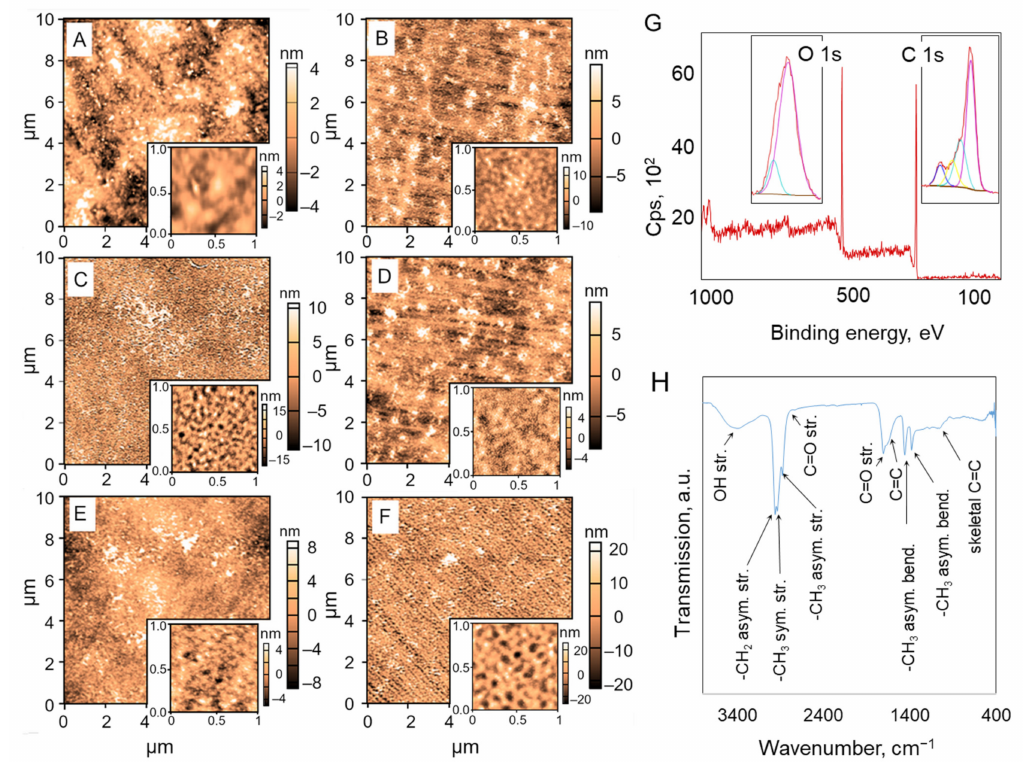
Figure 2. Surface morphology and chemical composition of plasma polymer coatings with a thickness of 500 nm. ( A – F ) Representative atomic force microscope (AFM) micrographs of surfaces of coatings deposited on PET substrata ( A ) at 10 W ( B ), 15 W ( C ), 20 W ( D ), 25 W ( E ), and 30 W ( F ). Scanning area for the main image is 10 × 10 µ m, scanning area for the insets is 1 × 1 µ m. ( G ) X-Ray Photoelectron Spectroscopy (XPS) wide spectrum for coatings deposited at 15 W. The inset shows the high-resolution scans for oxygen and carbon. ( H ) Fourier Transform Infrared (FTIR) spectrum for coatings deposited at 15